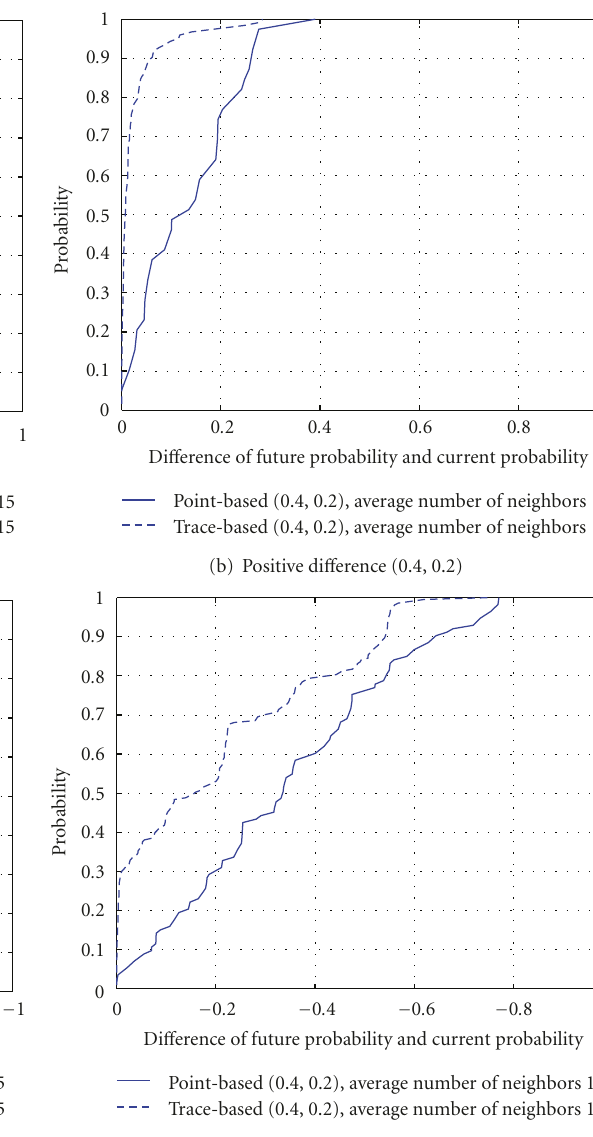
1 MB to 5 MB, and each node recording its trajectories every Y = 2 seconds. We observed that small overhead fraction values in percentage that are always less than